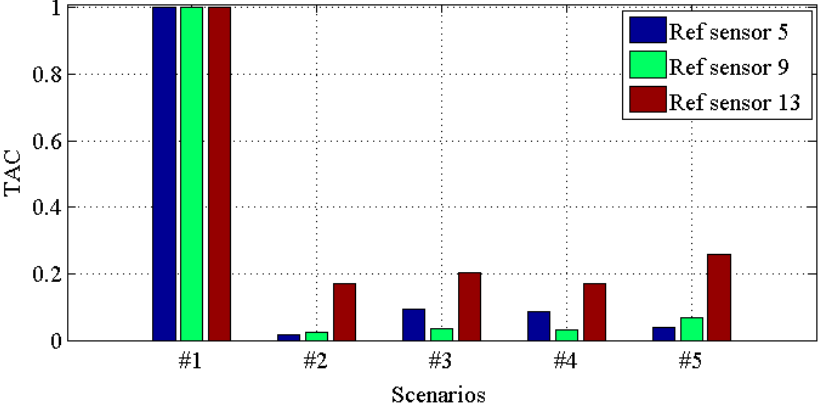
Figure 14. TAC for transmissibilities T(1, :), T(5, :), T(9, :) and T(13, :) with reference sensor 5, 9 and 13